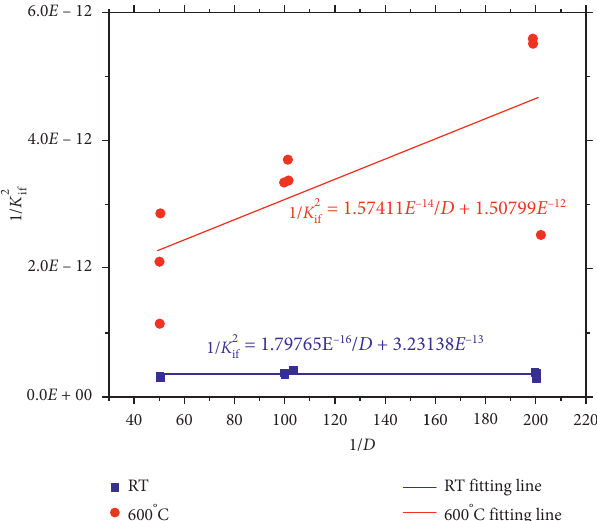
Figure 10: Linear regression for data from specimens of untreated granite samples and after 600 ° C treatment.